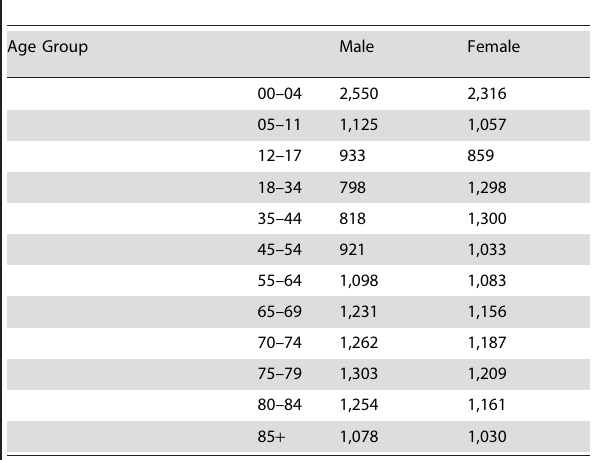
Table 8. Healthcare expenditure.